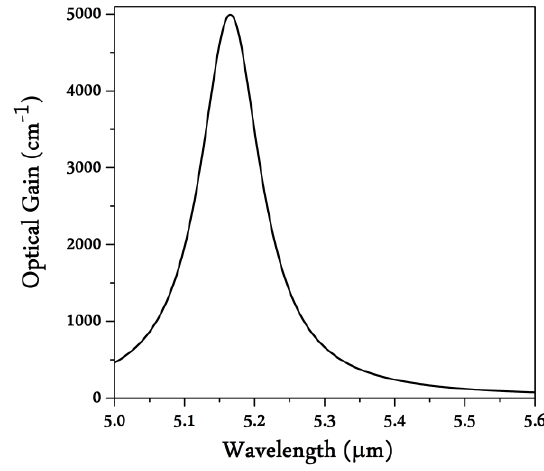
Figure 17. Calculated optical gain spectra for semipolar (202 ̅ 1)-oriented In 0.35 Ga 0.65 N single QW for charge carrier density of 7 × 10 12 cm −2 .